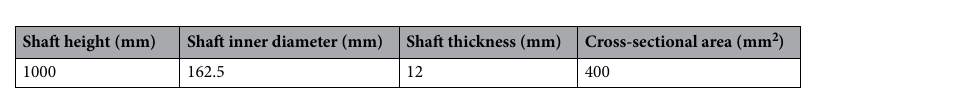
Table 4. Geometric parameters of shaft experimental